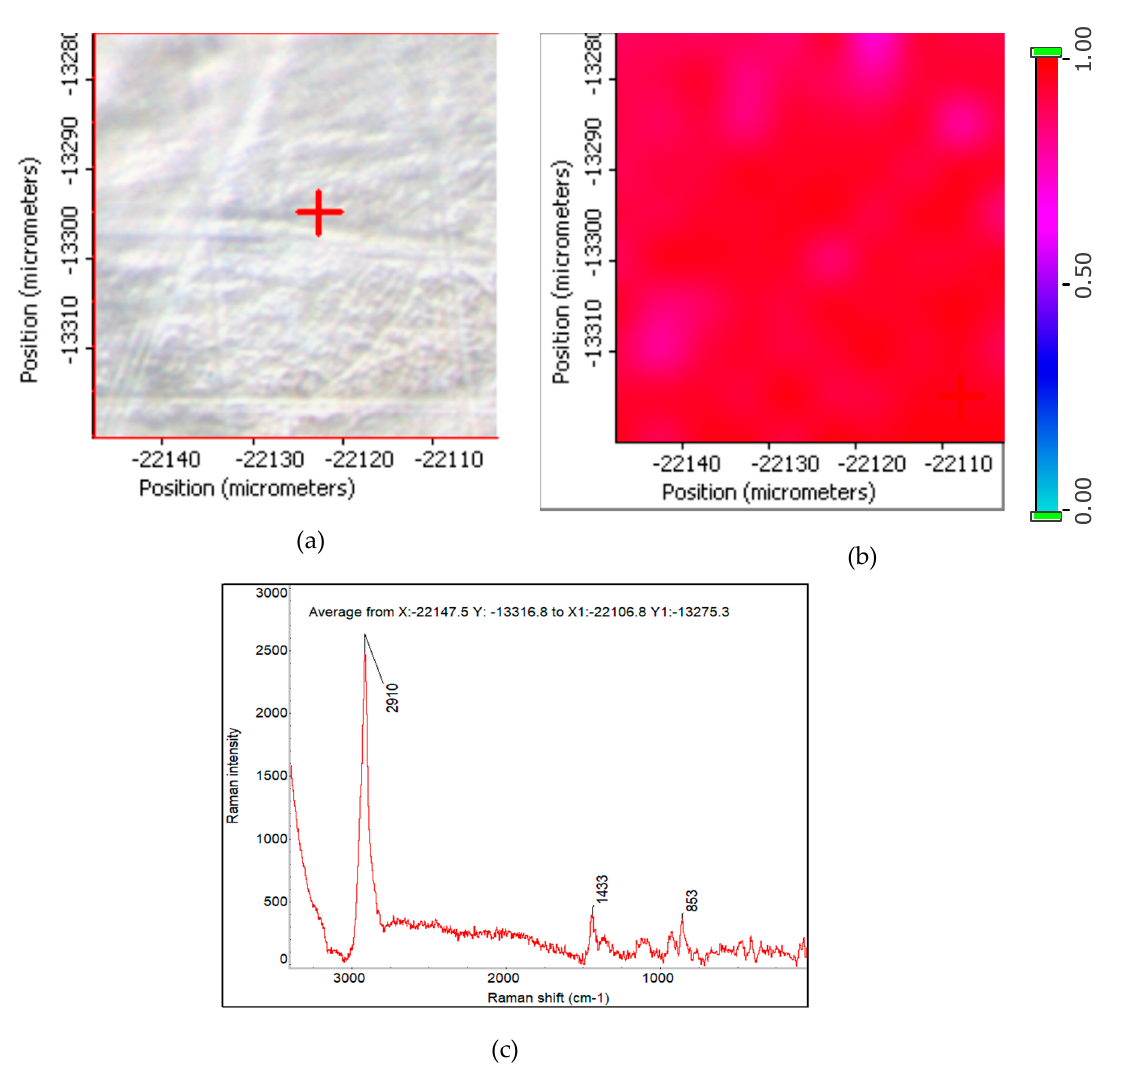
Figure 6. ( a ): Raman image of PVA membrane; ( b ) Optical image of the same area 70 um × 70 um. ( c ) The average spectrum of the Raman mapping area (it is used as correlation spectrum). Raman Imaging of PVA_GO_CNT_COOH